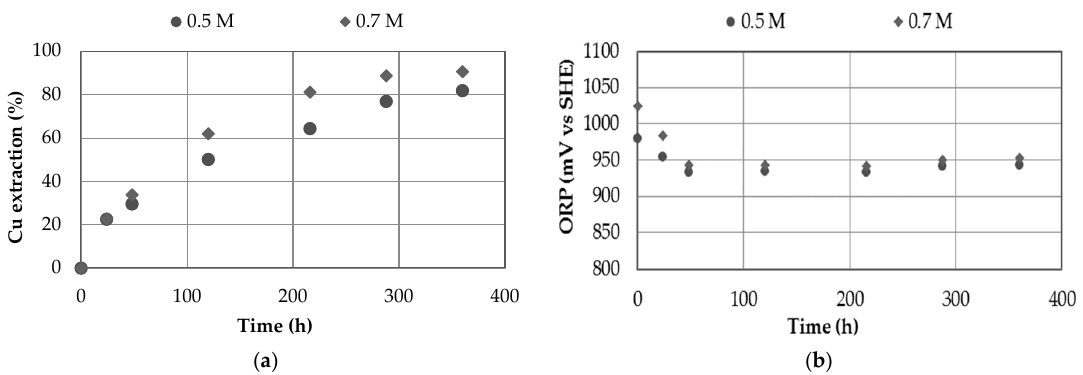
Figure 3. ( a ) Copper extraction (%) vs. time (h) at di ff erent sulfuric acid concentration: 0.5 and 0.7 M. ( b ) Redox potential (mV) vs. time (h) at di ff erent sulfuric acid concentration: 0.5 and 0.7 M. Experimental conditions: [NaNO 3 ] = 0.7 M, seawater as dissolvent, 45 °C and sample A.